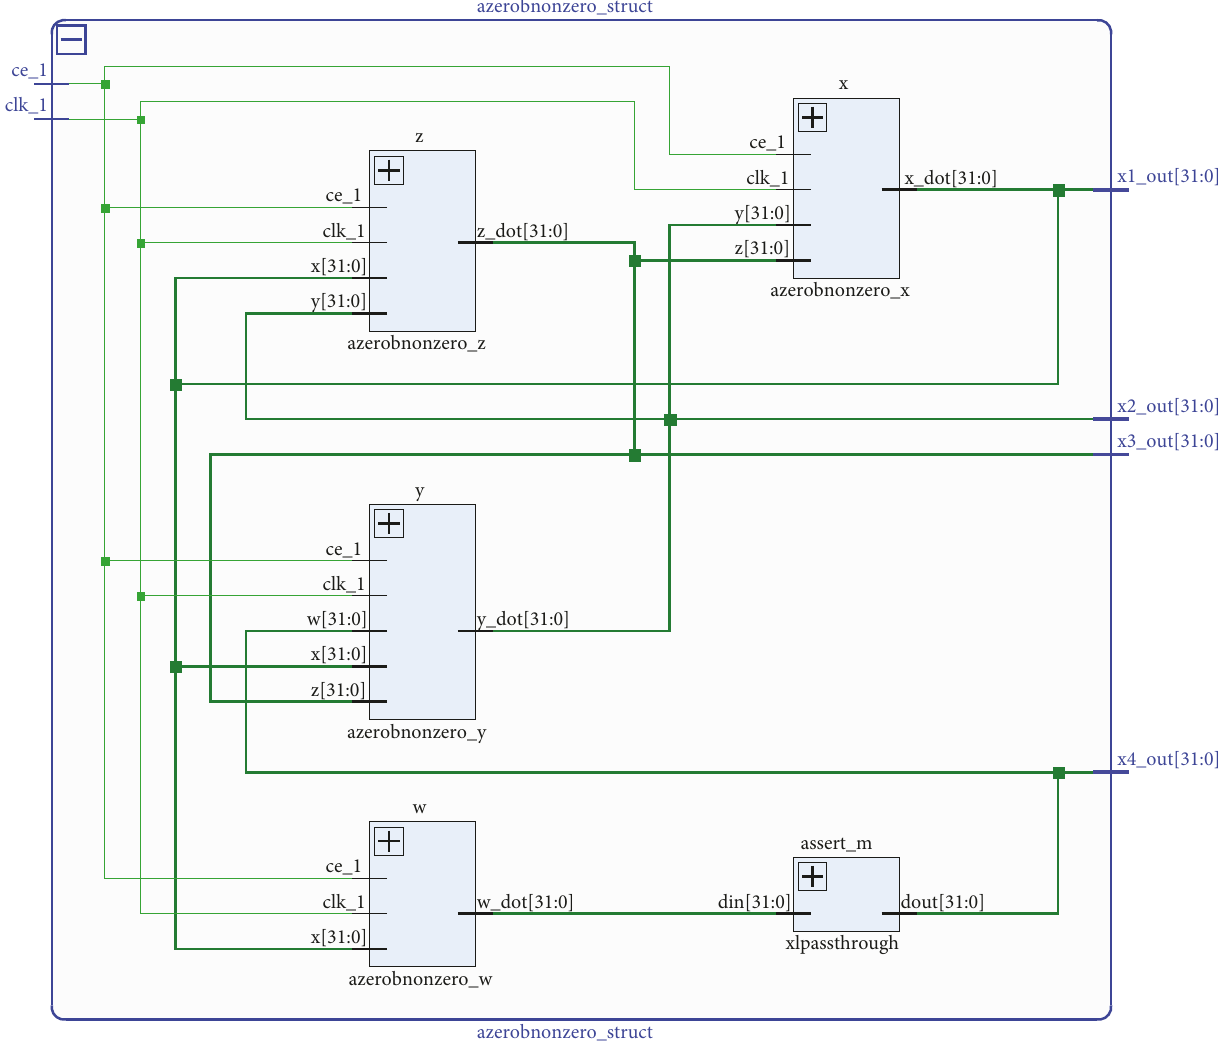
Figure 17: RTL schematics of FONCS-1 system.